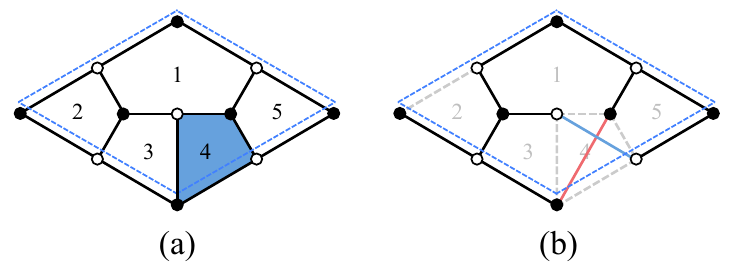
Figure 38. Backreaction of an instanton on face 4 of phase 2 of dP 2 .